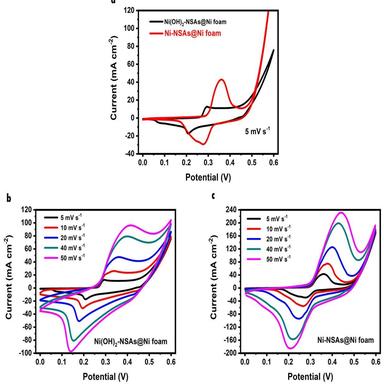
Shows CV curves of (a) Ni(OH)2-NSAs@Ni foam and Ni-NSAs@Ni foam at scan speed rate of 5 mV s−1 , (b, c) Ni(OH)2-NSAs@Ni foam and Ni-NSAs@Ni foam at various scan speed rate, respectively.